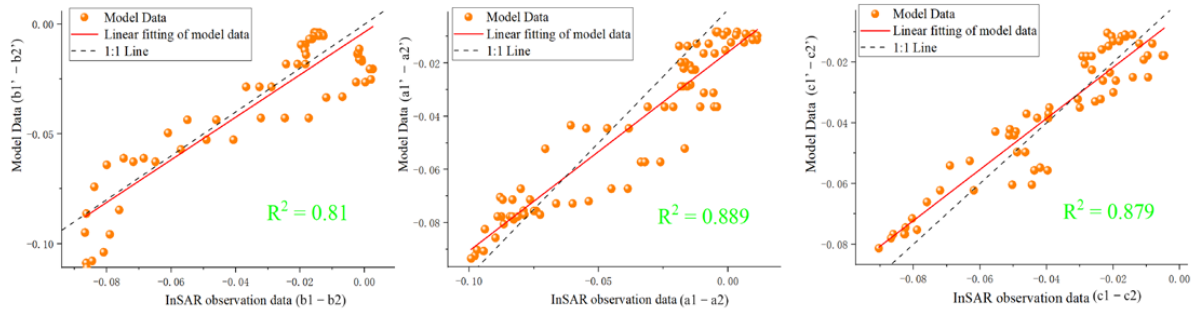
Figure 7. Correlation analysis diagram of the InSAR observation deformation and simulation defor- mation on the profile line in the subsidence area.